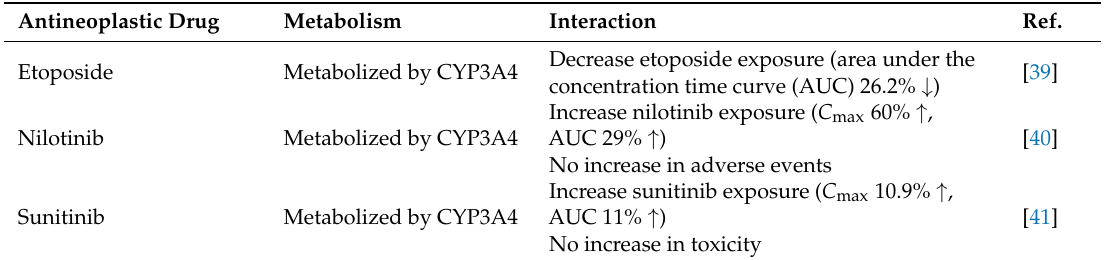
Table 1. Reported interactions between grapefruit juice and selected anti-neoplastic drugs.